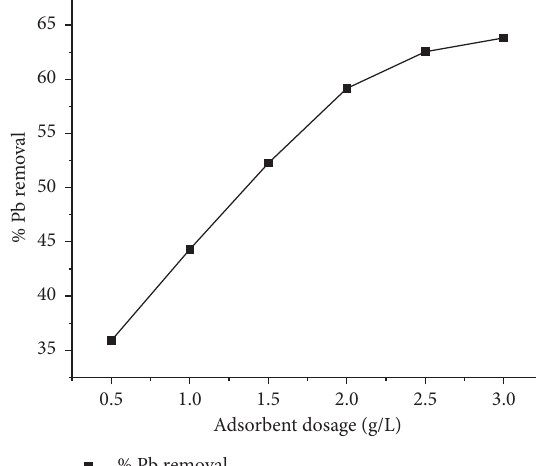
Figure 3: Efects of adsorbent dosage on lead removal.